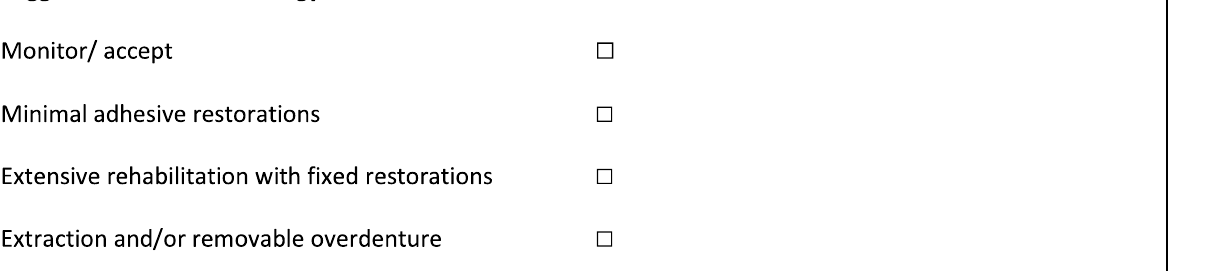
Figure 1. First classification tool in the pilot